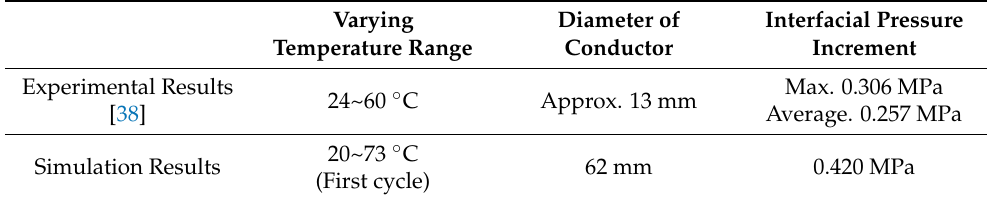
Figure 12. The radial stress and electric field intensity with time at the two interfaces ( a ) Inner semi-con/XLPE interface; ( b ) XLPE/SiR interface. Table 4. Comparison of XLPE/SiR interfacial pressure increment between experimental data and simulation.